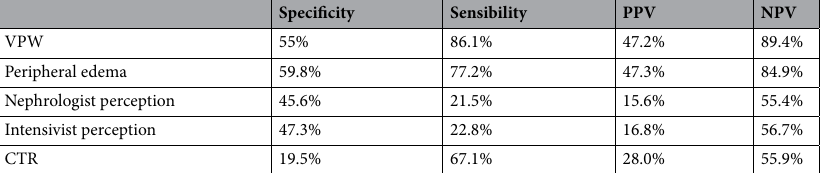
Table 3. Sensibility, specificity, and positive and negative predictive values of the variables for the detection of hypotension. VPW vascular pedicle width, CTR cardiothoracic index, PPV positive predictive value, NPV negative predictive